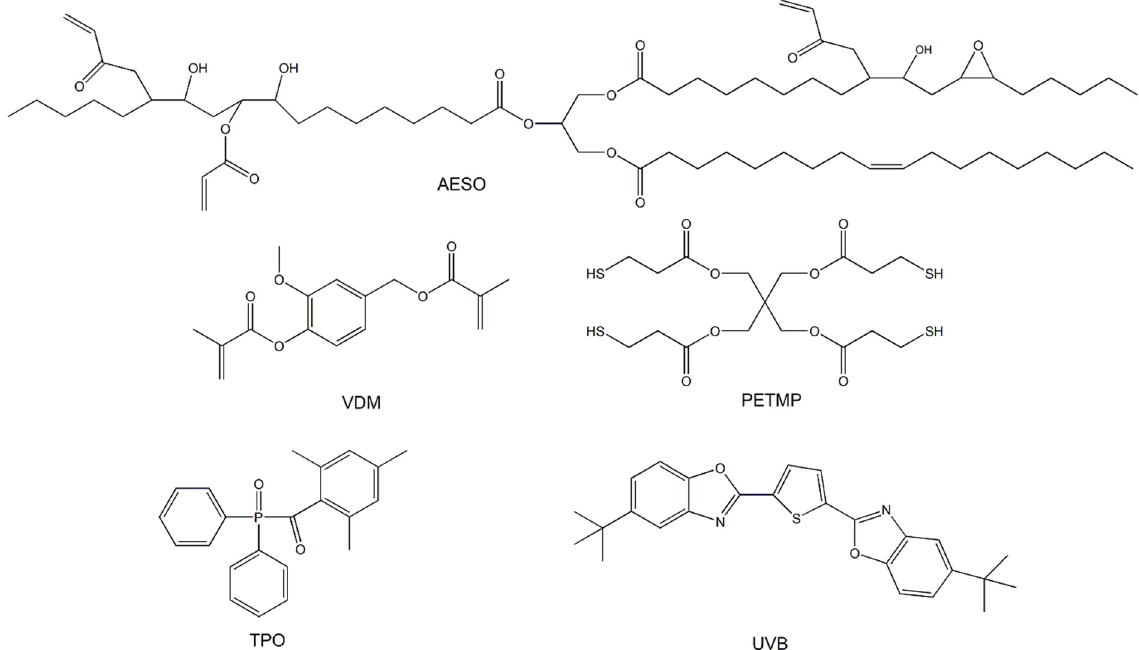
Figure 1. Chemical structures of acrylated epoxidized soybean oil (AESO), vanillin dimethacrylate (VDM), pentaerythritol tetrakis(3-mercaptopropionate) (PETMP), and diphenyl(2,4,6- pentaerythritol tetrakis(3-mercaptopropionate) (PETMP), and diphenyl(2,4,6-trimethylbenzoyl) phos- trimethylbenzoyl) phosphine oxide (TPO). phine oxide